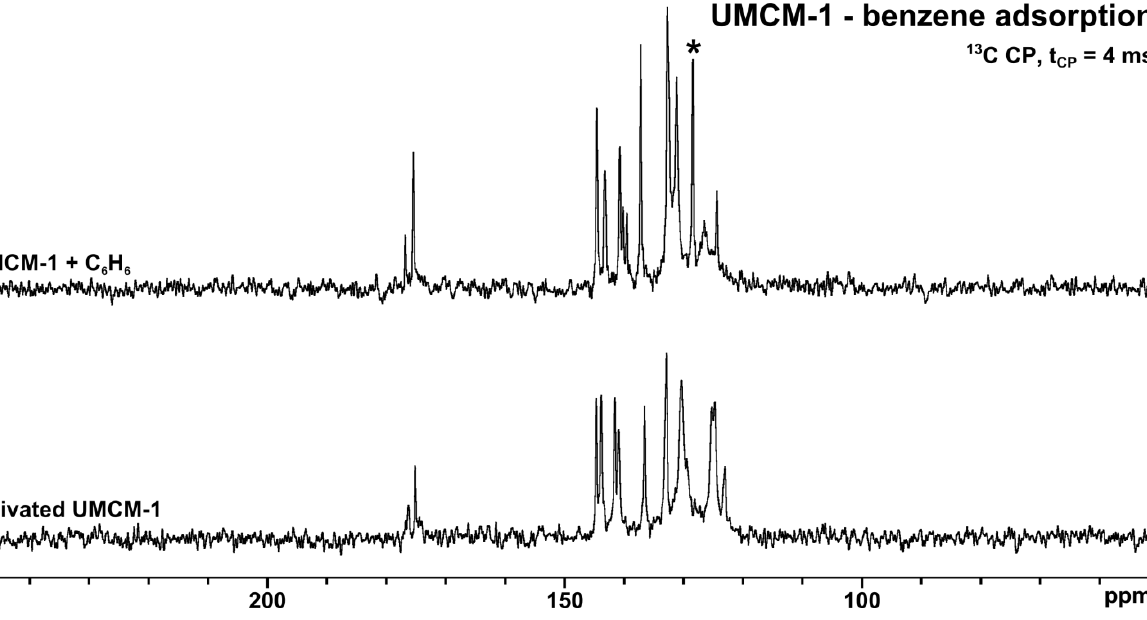
Figure 7. 13 C{ 1 H} CP MAS NMR spectra of activated and C respectively. The signal due to C